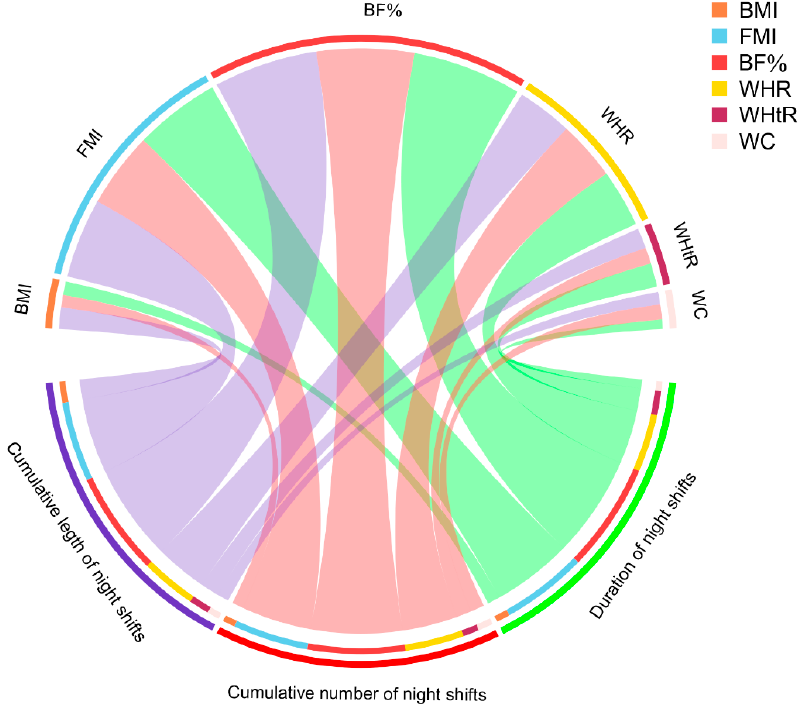
Figure 1. Chord diagram for partial correlations of different exposure metrics of night shift work with FMI and BF%. The width of the arcs in different colors represents the magnitude of the partial Spearman correlation coefficient. BMI, body mass index; BF%, body fat percentage; FMI, fat mass index; WC, waist circumference; HC, hip circumference; WHtR, waist-to-height ratio; WHR, waist-to-height ratio. Table 2. Associations of different exposure metrics of night shift work with BMI, BF%, and FMI from generalized linear models. Exposure